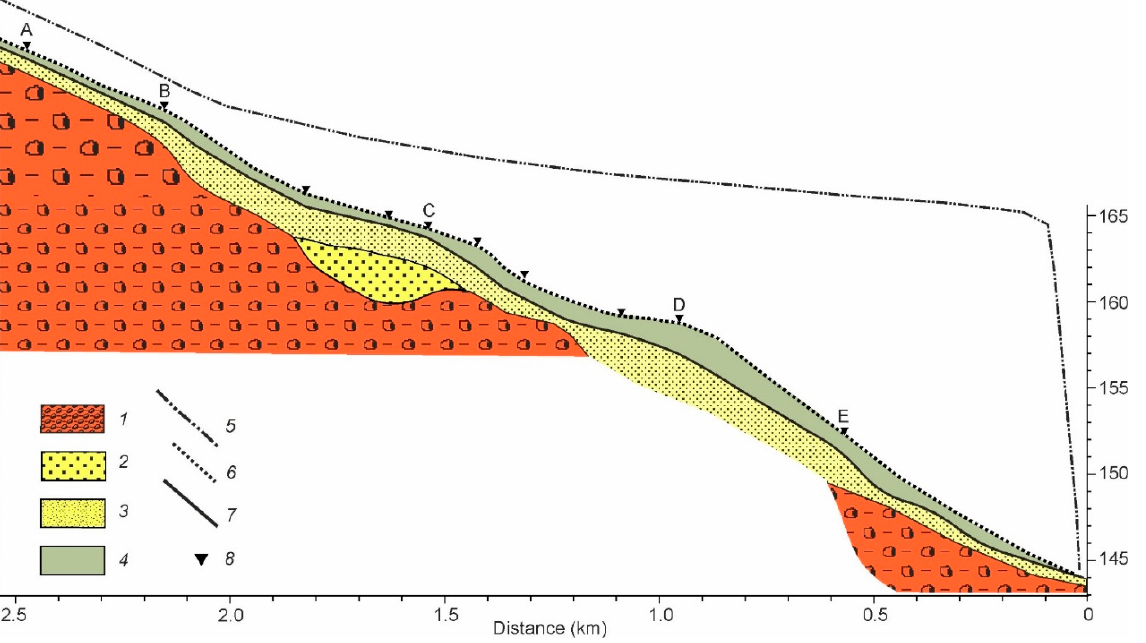
Figure 9. Longitudinal profile of the Yazvitsa Balka. Keys: 1—MIS 6 moraine, 2—glaciofluvial sand, 3—Holocene sand and sand with gravel, 4—Holocene deposits of the balka terrace (sand and loam),